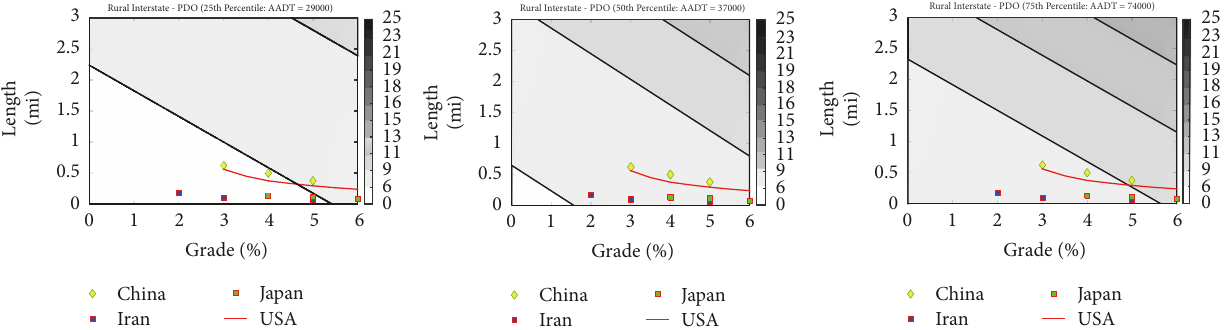
Figure 8: Prediction of rural interstate PDO crash frequency.